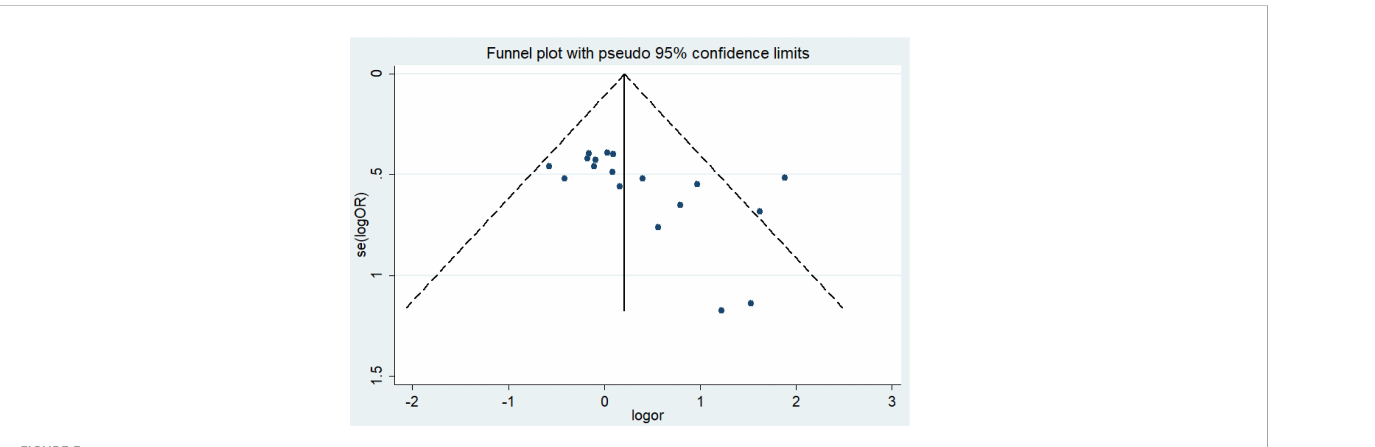
FIGURE 3 Funnel plot of asymmetry test of the publication bias of literatures.